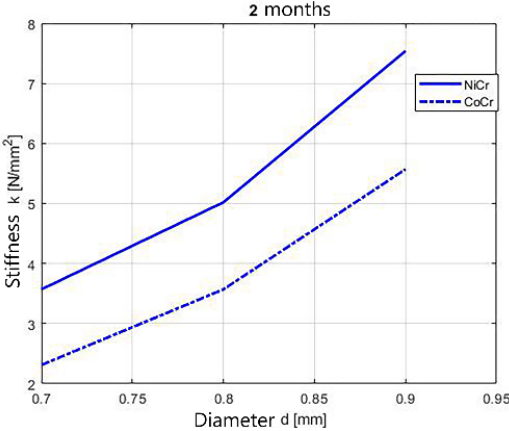
Figure 14. Stiffness dynamics of orthodontic wires, 1 month immersion.